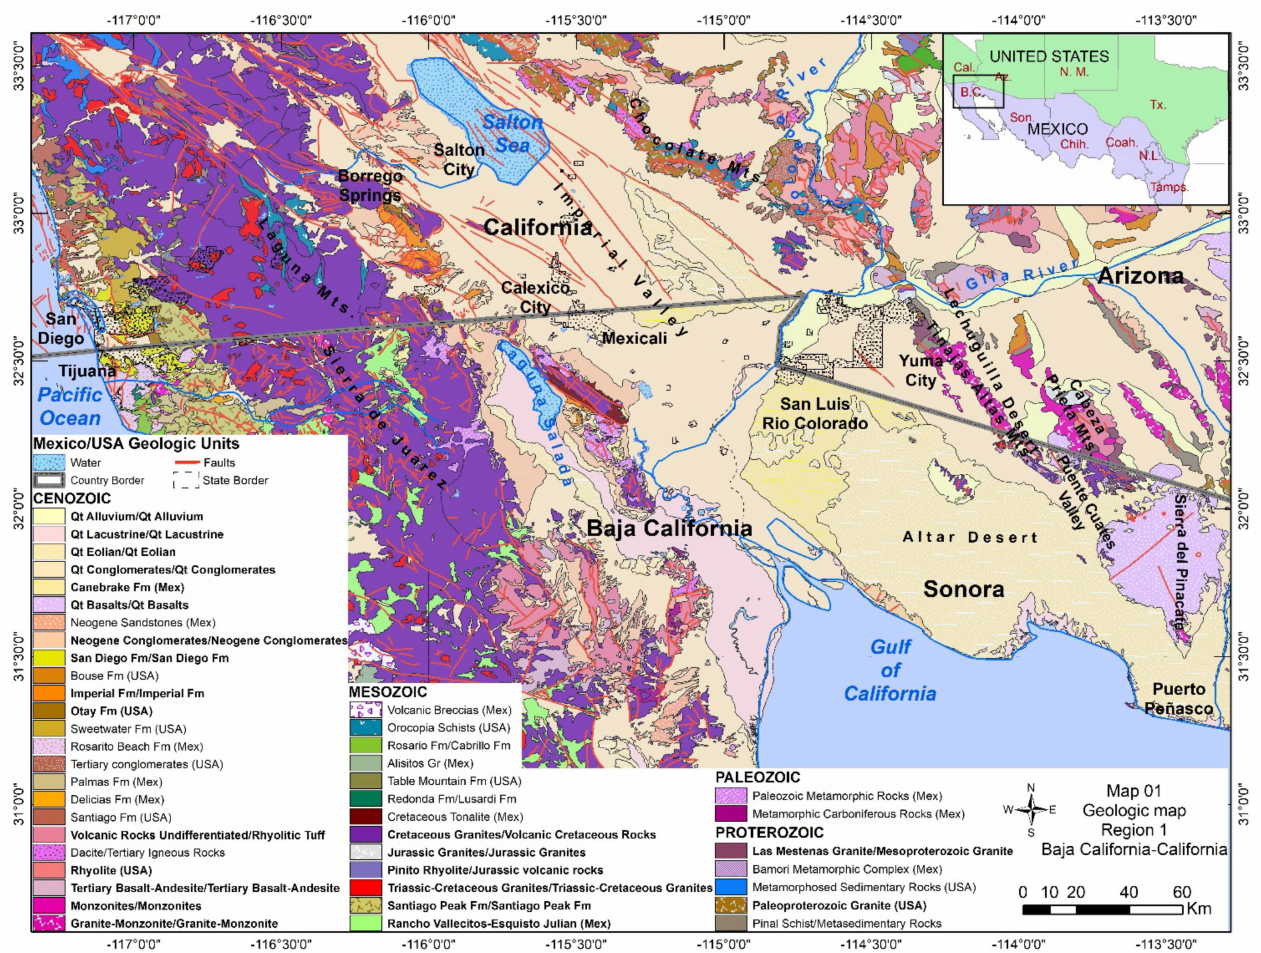
Figure 1. Geologic map, Baja